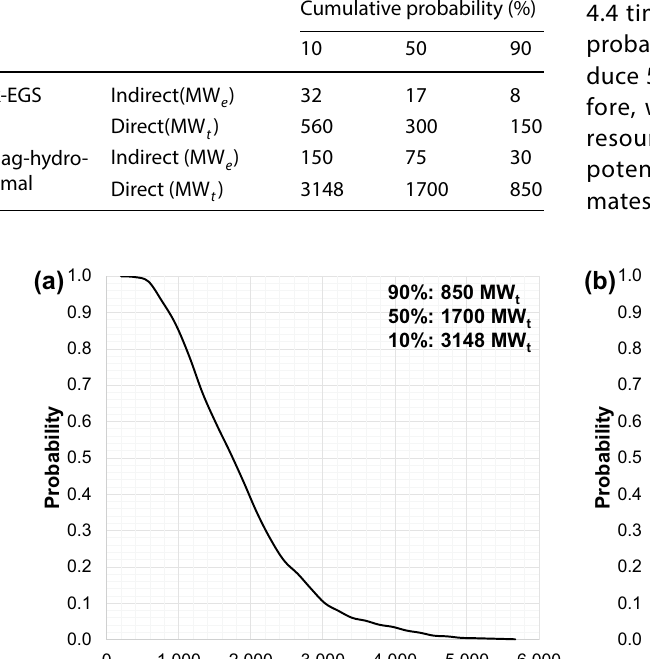
Table 2 Power output of each case in with 10%, 50% and 90% probability, respectively (for real volume of reservoirs) Cumulative probability (%)